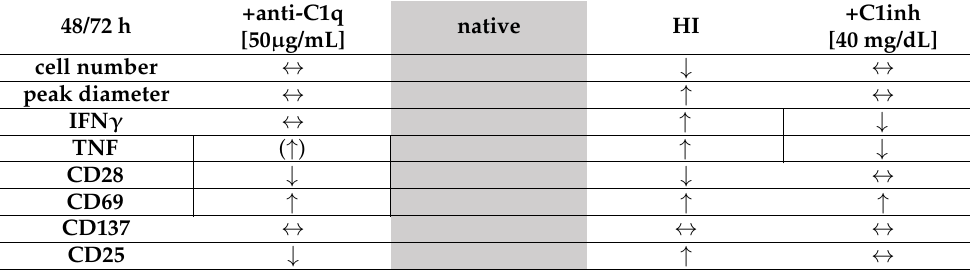
Table 2. Schematic illustration of the effects of HI, HI + C1inh, and native + anti-C1q on human CD4+ T cells compared to cells in native serum. Effects are analyzed after 72 h (HI, HI + C1inh) and 48 h (native + anti-C1q), respectively. Each arrow represents a significantly increased ( ↑ ), significantly decreased ( ↓ ) effect or no significant effect ( ↔ ). Effects being also induced by the carrier solution are depicted as no significant